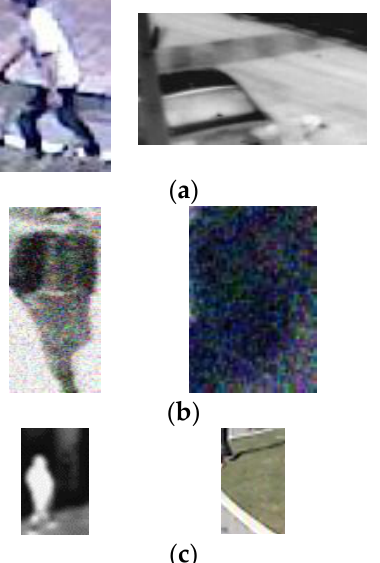
Figure 14. Examples of correct classification with ( a ) original DVLFPD-DB1, ( b ) degraded DVLFPD- DB1, and ( c ) OSU color-thermal database. In ( a – c ), left and right images show the examples of TP and TN candidates, respectively.